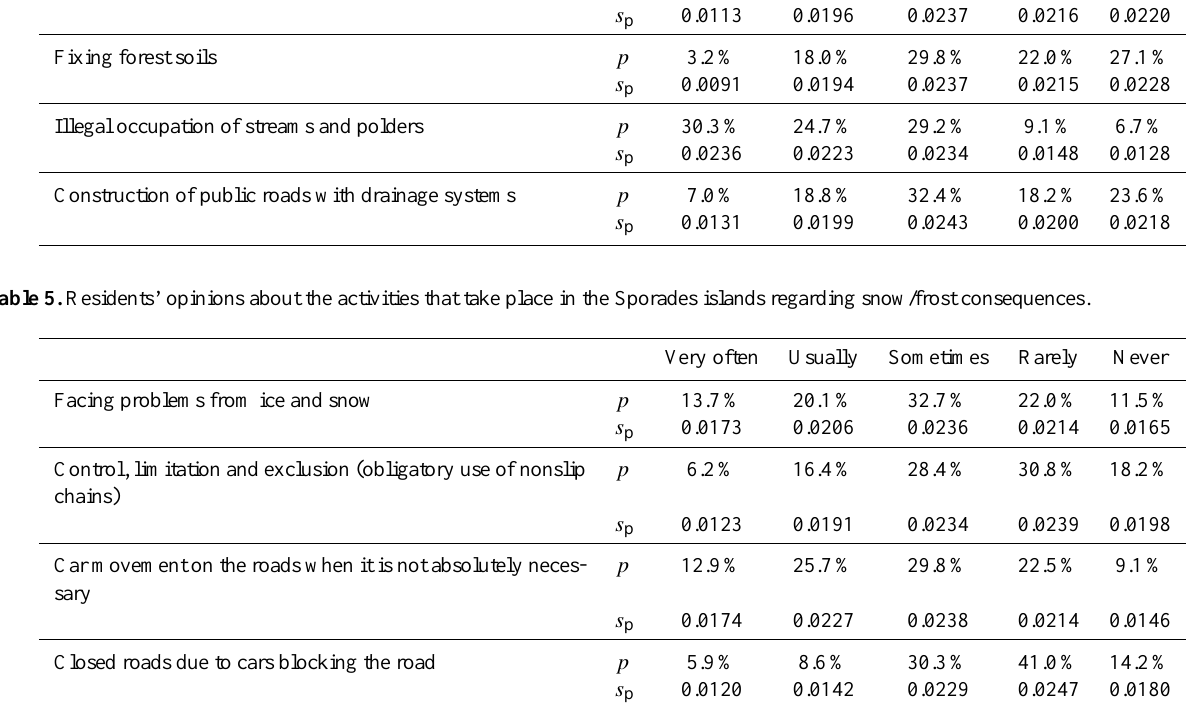
Table 4. Residents’ opinions about the activities that happen in the Sporades islands that affect the consequences of floods. Very often Usually Sometimes Rarely Never